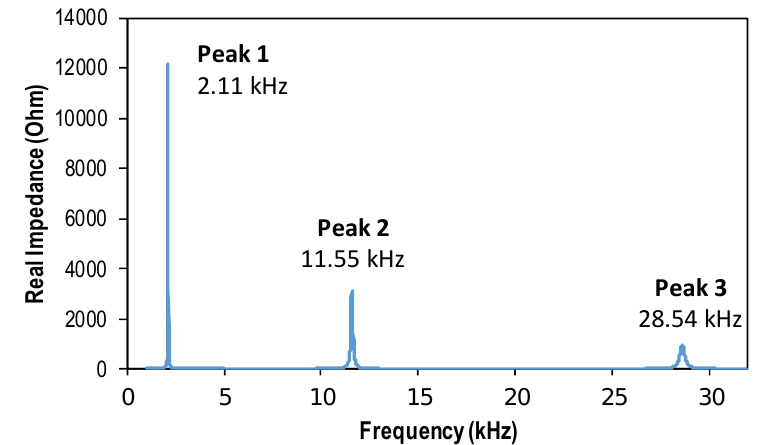
Figure 5. Sensitive frequency range of wearable PZT interface.